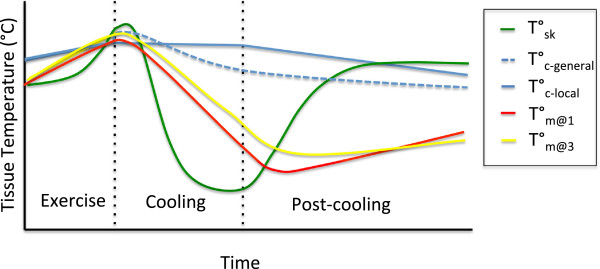
Relative pattern of temperature change in different tissue layers during exercise, cooling and post-cooling period. Data are averaged from studies measuring changes in tissue temperatures using various forms of cryotherapy [4,9,43,45-48,54,55]. Skin temperature (green, Tsk) increases during exercise, decreases exponentially through cryotherapy, reaching nadir earliest, and increases exponentially through post-cooling period. Core temperature (blue dashed, Tc-general) changes induced by cryotherapy applied to large mass increases during exercise, and decreases during cryotherapy (rate dependent on thermal gradient and peripheral blood flow). Core temperature cools slower than other tissues and does not begin to return to baseline until 1 h post-cooling. Core temperature (blue solid, Tc-local) changes induced by cryotherapy applied to a small mass is minor during cryotherapy and modest throughout post-cooling period as blood cooled at periphery is returned to core. Superficial intramuscular temperature (red, Tm@1) increases during exercise, declines linearly during cryotherapy, and increases linearly to baseline within 1 h. Deeper intramuscular temperature (yellow, Tm@3) increases during exercise decreases linearly during cryotherapy at a lower rate than Tm@1, continues to cool through the post-cooling phase as heat is transferred to warmer superficial tissues, returning to baseline later than 1 h.